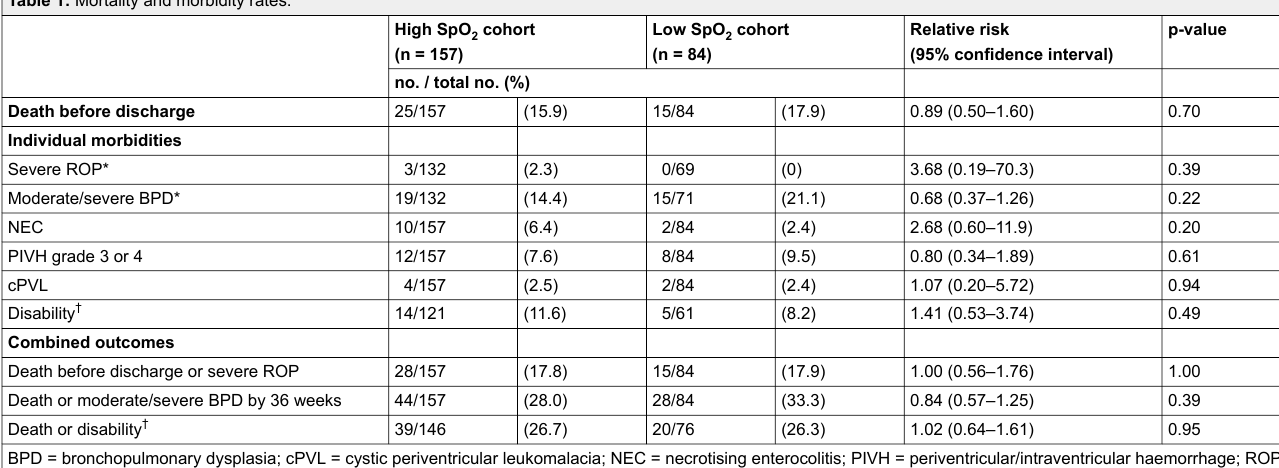
Table 1: Mortality and morbidity